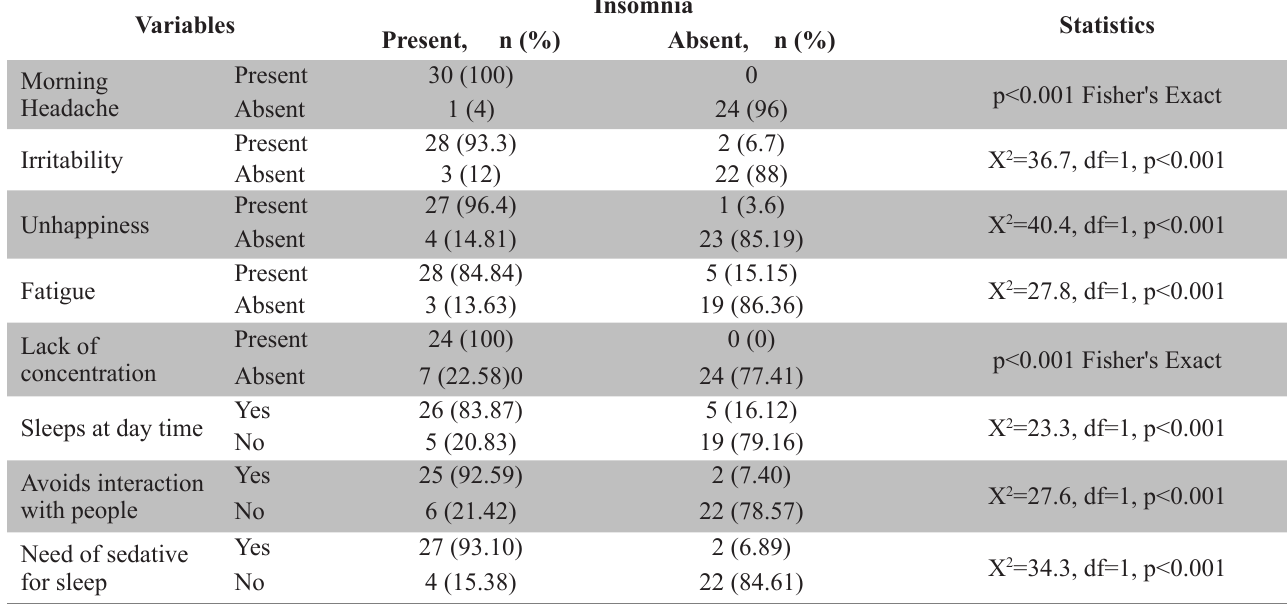
Table 4: Effects of insomnia and their relationship with